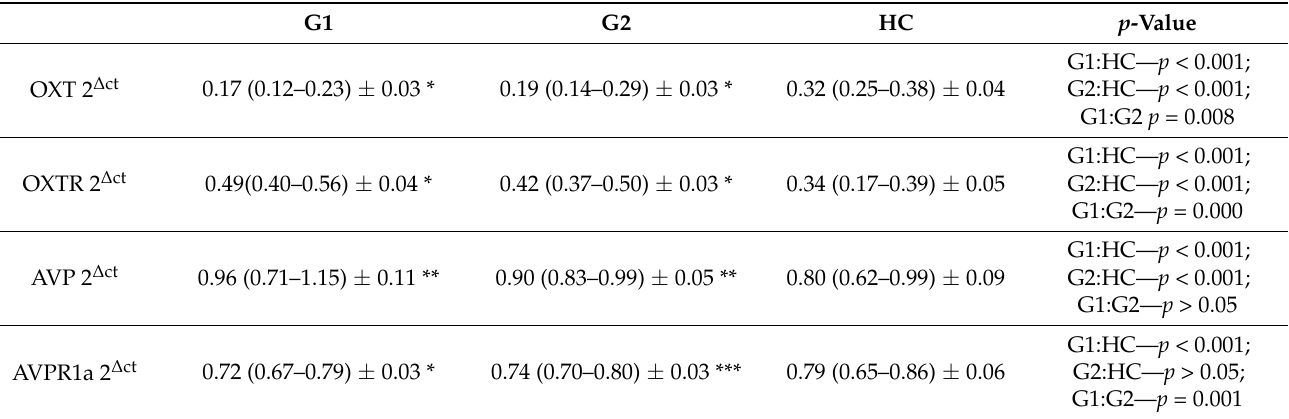
Table 1. OXT, OXTR, AVP, and AVPR1a gene expression at the mRNA level. * Statistically significant difference between all groups; ** statistically significant difference between the control group; *** sta- tistically significant difference between the second study group; p —statistical significance; median (minimum–maximum), ± —standard